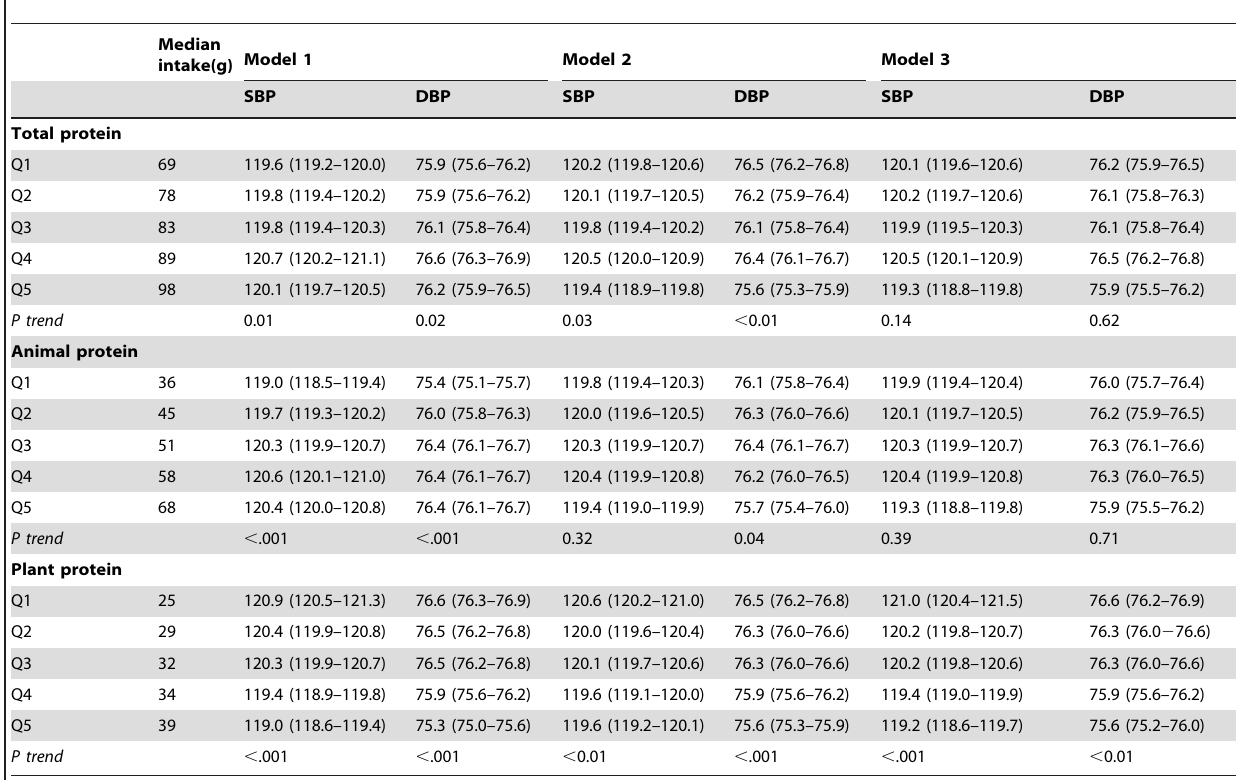
Table 2. Fully adjusted systolic and diastolic BP levels in 20,820 untreated Dutch adults in quintiles of energy adjusted total, animal and plant protein